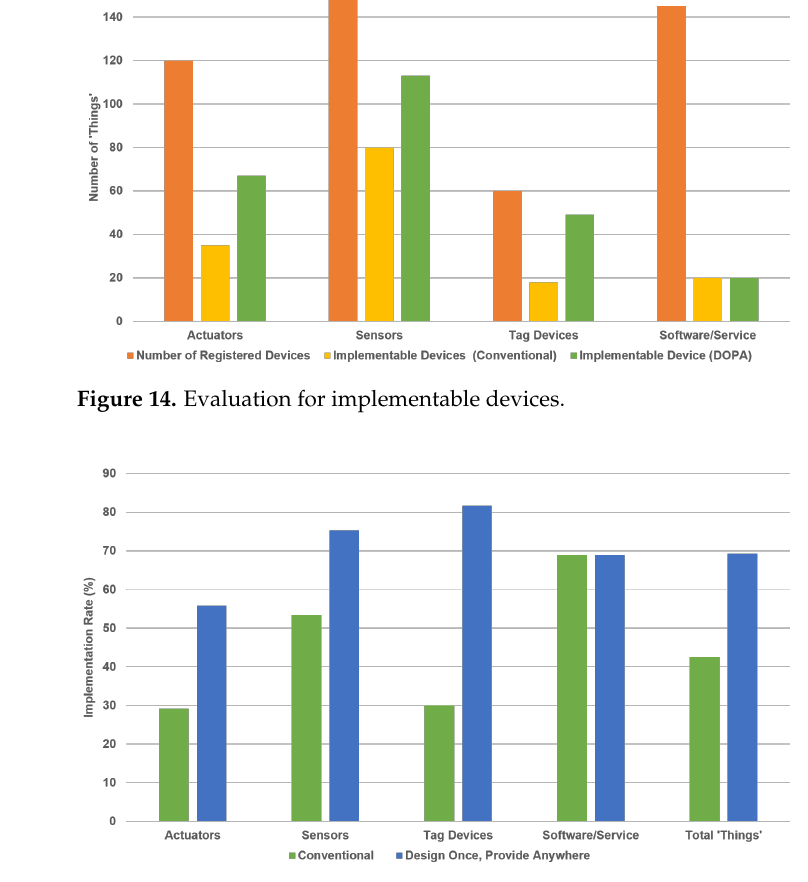
Figure 15. Evaluation for implementation